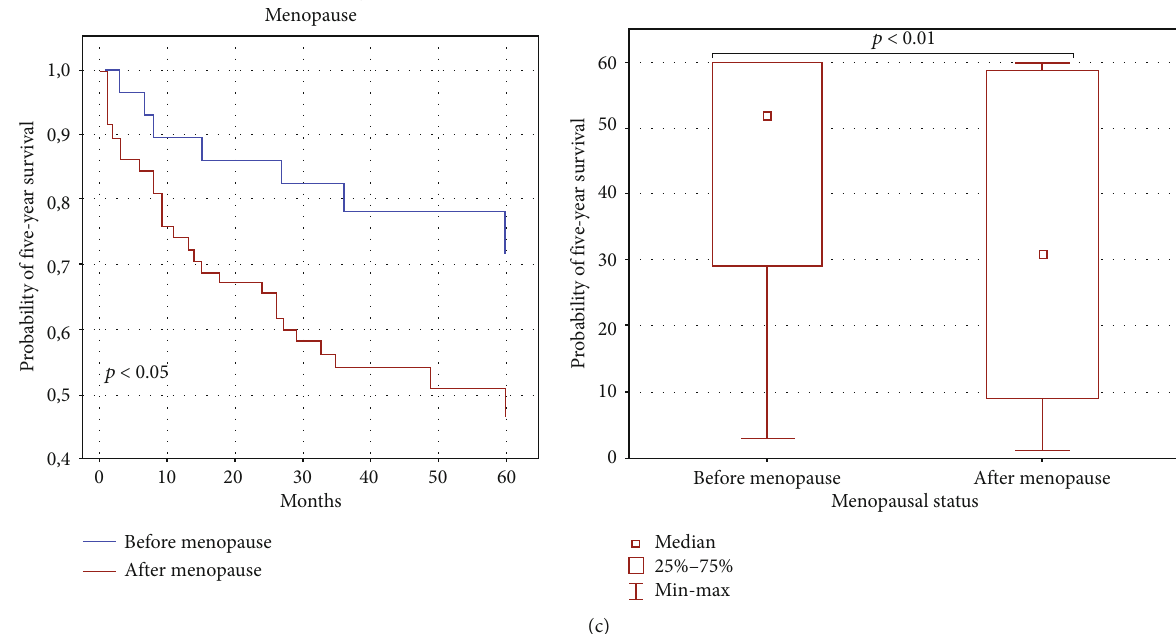
Figure 7: Relationship between clinical parameters and 5-year survival of OC